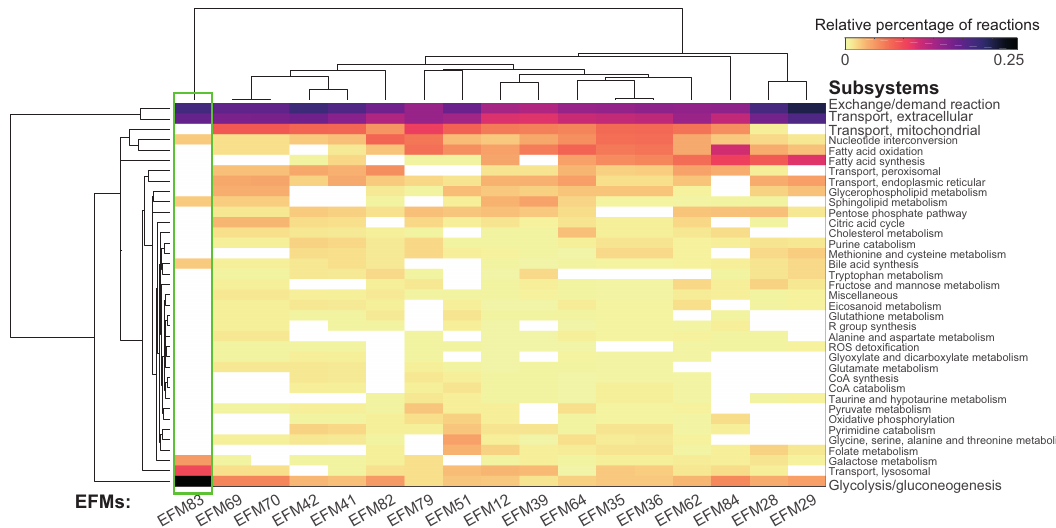
Figure 3. Subsystem occurrence in the significantly enriched EFMs indicating distribution of reactions across different subsystems. Seventeen of the EFMs that take up glucose and release lactate, were found to be significantly upregulated in cancer. The subsystems in the EFM selected for visualization are highlighted in the green